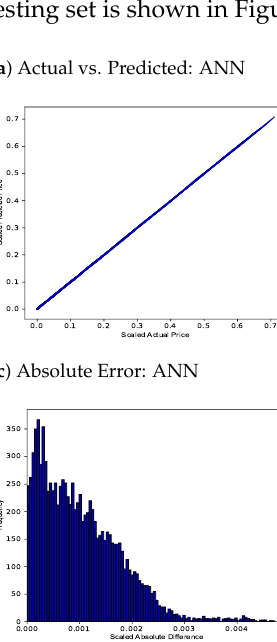
Figure 7. Actual vs. predicted results: fully